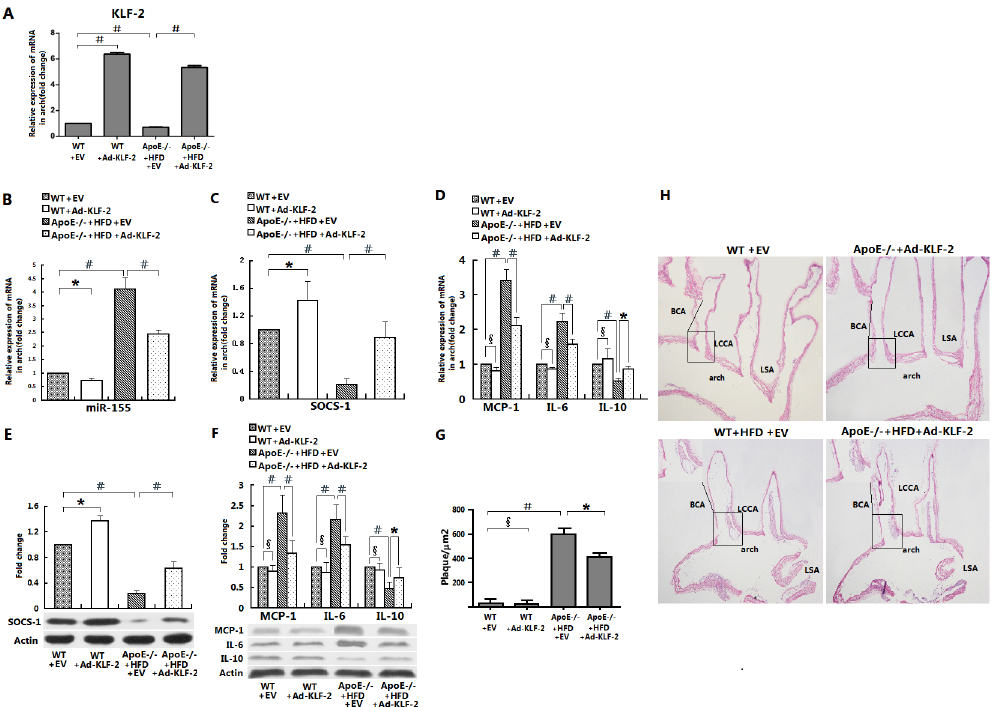
Fig 4. Effects of KLF2 on miR-155/SOCS-1 and cytokine gene expression and the formation of atherosclerotic lesions in the aortic arches of apoE- deficient mice. Five-week-old male littermate apoE -/- mice and WT controls were fed a high-fat, high-cholesterol diet (HFD) and a normal diet, respectively. Mice were randomly divided into the following four groups: WT+EV, WT+Ad-KLF2, apoE -/- +HFD+EV, and apoE -/- +HFD+Ad-KLF2. After 18 weeks on an atherogenic diet, the mice were euthanized, and the arch portions of their aortas were harvested for analysis. KLF2, miR-155, and SOCS-1 expression in the aortic arch were analyzed by RT-PCR, and the areas of atherosclerotic lesions in aortic arch regions were detected by hematoxylin – eosin staining. Bar graphs indicate relative mRNA levels for KLF2 normalized to GAPDH mRNA levels (A); miR-155 normalized to U6 mRNA levels (B); SOCS-1 normalized to GAPDH mRNA levels (C); and cytokine genes (MCP-1, IL-6, and IL-10) normalized to GAPDH mRNA levels (D). SOCS-1 (E) and cytokine (F) protein expression in the aortic arch were detected by Western blotting. Treatment with Ad-KLF2 was associated with a reduction in aortic arch atherosclerosis among apoE -/- mice fed an HFD. The brachiocephalic trunk artery (BCA), left common carotid artery (LCCA) and left subclavian artery (LSA) are indicated in the figure (H). Ad-KLF2 treatment produced a reduction in the size of atherosclerotic lesions. Photomicrographs of longitudinal sections of the mouse aortic arch-wall region were analyzed by computer-assisted image quantification (G) (#, * , and δ indicate p < 0.001, p < 0.05, and p > 0.05, respectively, for the indicated comparisons).